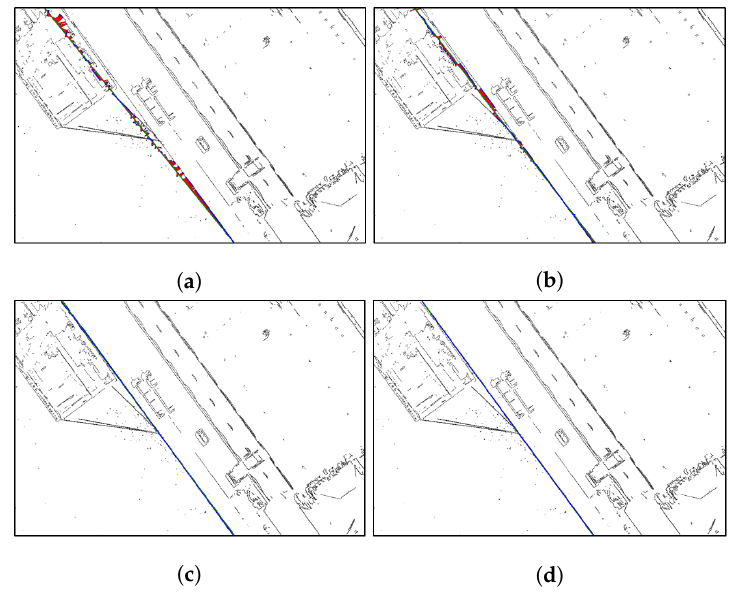
Figure 11. The processed image No. 5 with the boundary of the land area marked based on the ENC: ( a ) Iteration No. 1, ( b ) Iteration No. 2, ( c ) Iteration No. 3, ( d ) Iteration No.